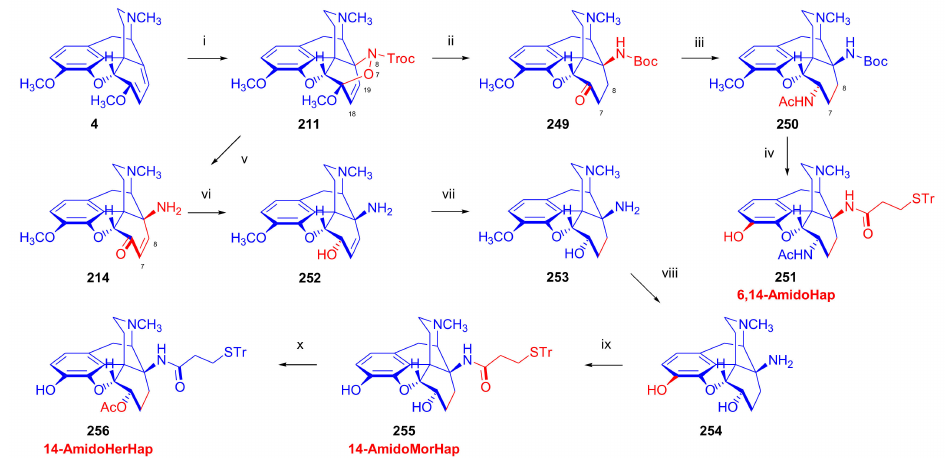
Figure 69. Synthesis of heroin vaccine haptens via HDA adduct of thebaine. Reagents and conditions :